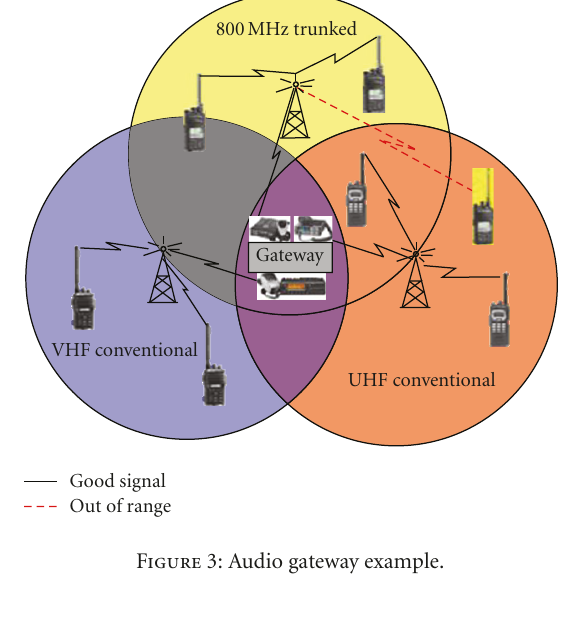
Figure 3: Audio gateway example.